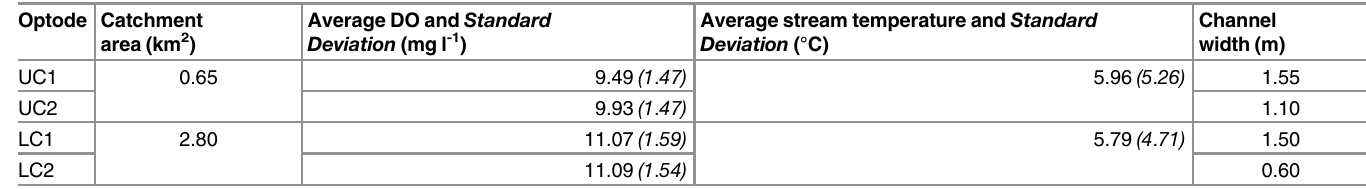
Table 1. Catchment size for each optode and average dissolved oxygen concentration and stream temperature for the common period of study. Optode Catchment Average DO and Standard Deviation (mg l -1 ) area (km 2 )